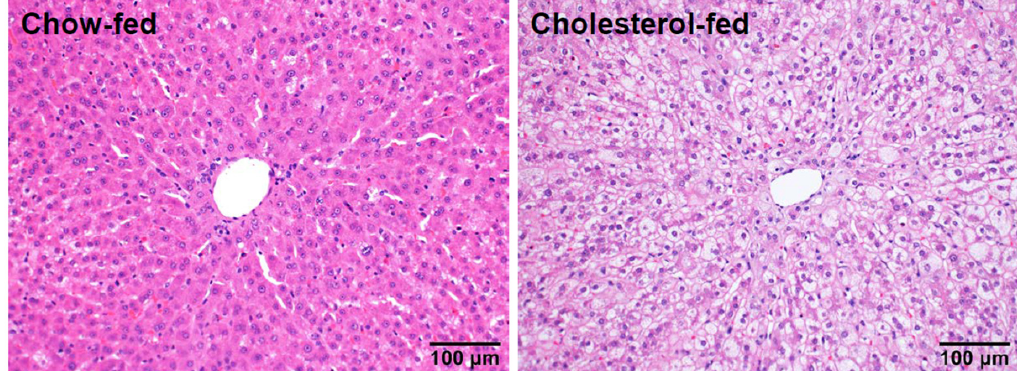
Figure 3. Histological images of livers of normal ( left ) and cholesterol-fed rabbits ( right ). Paraffin sections were stained by hematoxylin and eosin staining, and livers of cholesterol-fed rabbits exhibit features of steatosis with increased lipids in the cytoplasm.